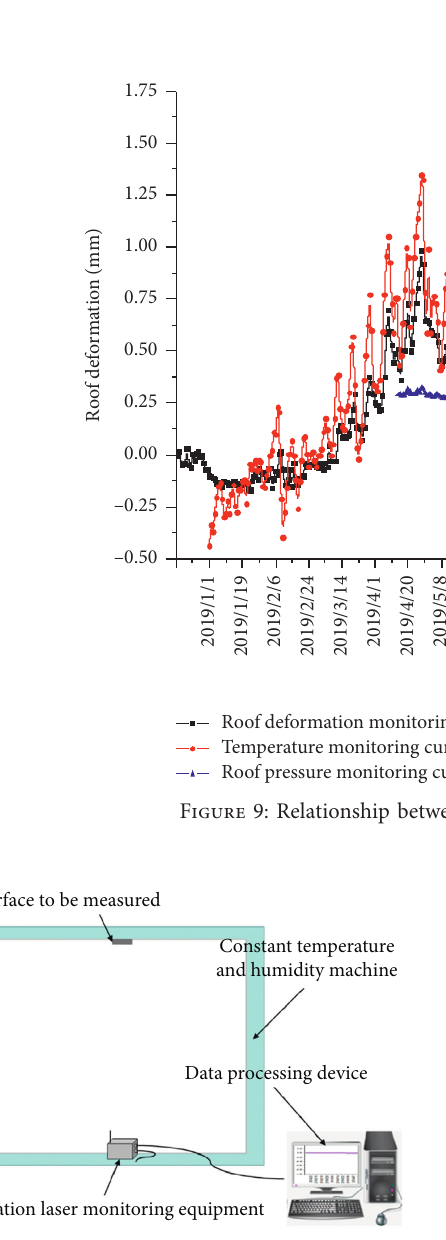
Figure 10: Schematic diagram of constant temperature and hu- midity machine experiment.